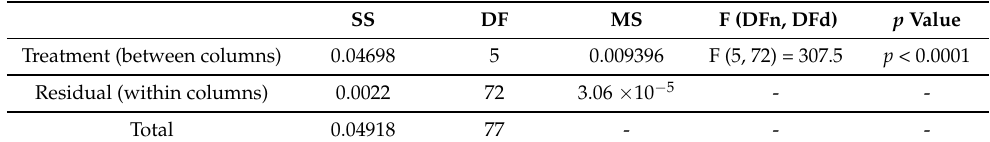
Table 10. ANOVA table of the proposed BO-CNN model vs. pre-trained-CNN models for the IDRiD dataset.